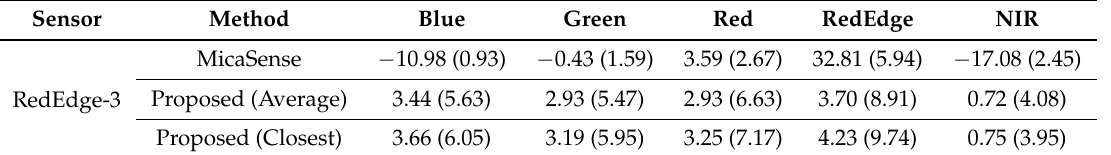
Table 4. Average percent errors in radiance imagery for all bands using both conversion methods for the RedEdge-3. Standard deviations are shown in parenthesis.